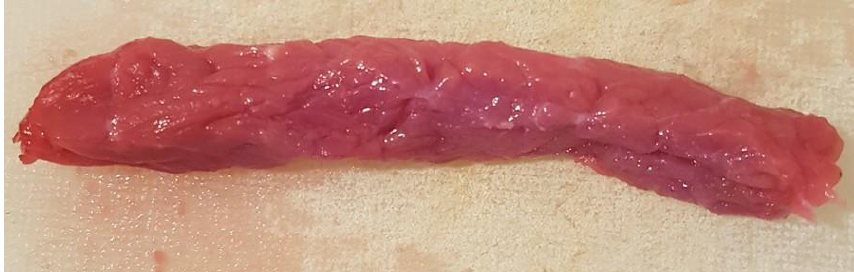
Figure 7. Raw beef formed into strips before